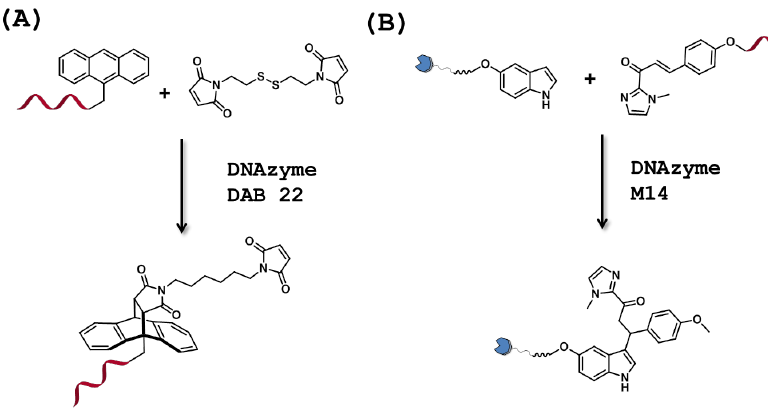
Figure 7. Reactions catalyzed by C-C bond-forming DNAzymes. ( A ) DNAzyme DAB 22 catalyzes the Diels-Alder reaction [149]; ( B ) DNAzyme M14 catalyzes the Friedel-Crafts alkylation reaction [150].